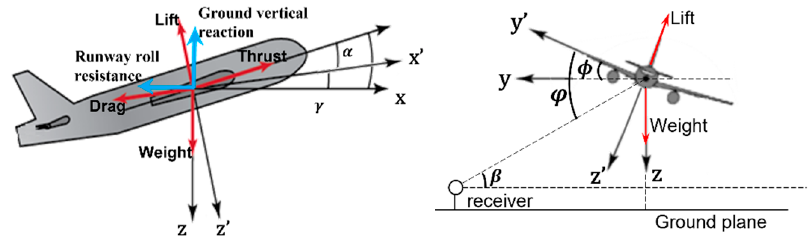
Figure A1. Forces exerted on the aircraft, as depicted in its longitudinal (left) or lateral (right) planes. Angles associated with the projection in the Earth (x, y, z) and aircraft stability (x’, y’, z’) reference frames: Angle-of-attack ( α ), flightpath ( γ ) and bank ( φ ) angles, along with the elevation ( β ) and depression ( 𝜑 ) angles.